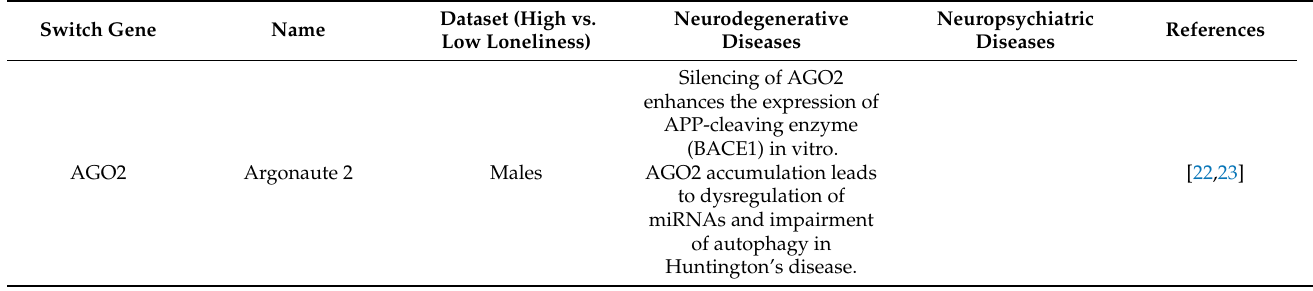
Table 1. Association of loneliness-related switch genes with neurodegenerative and neuropsychi- atric